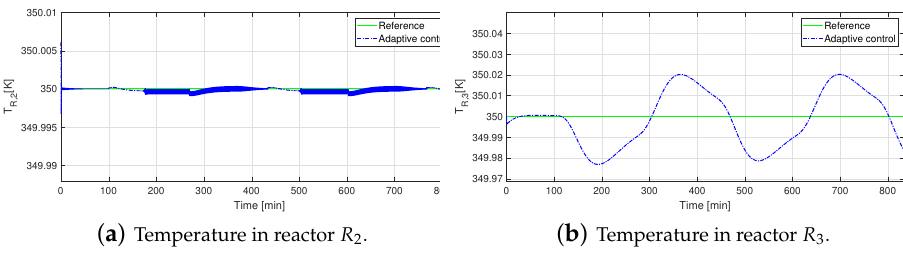
Figure 10. Performance of adaptive controller in presence of an abrupt change in temperature in reactor R 1 —output temperature T R ,2 and T R ,2